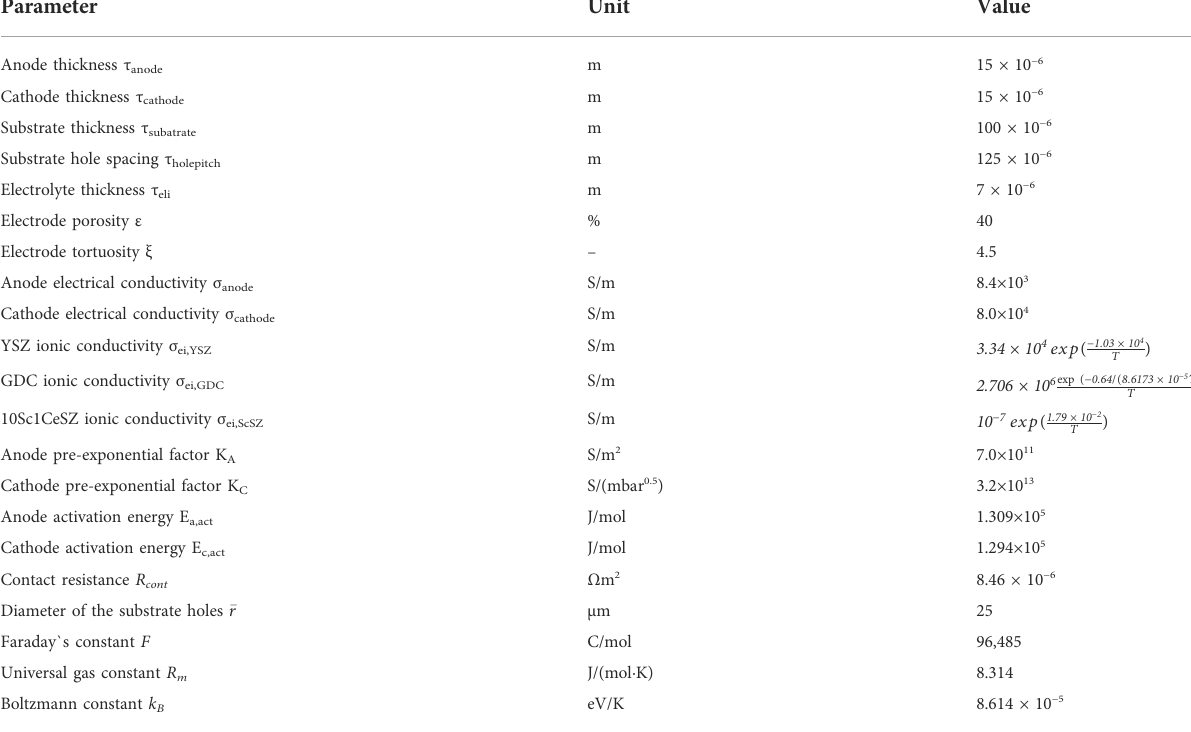
TABLE 1 The main parameters of the mathematical model.